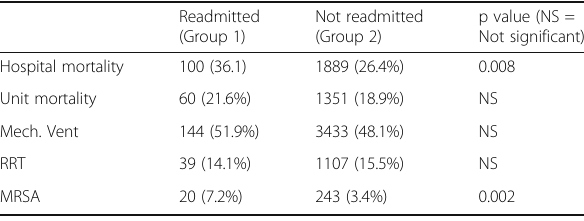
Table 113 (abstract A358).